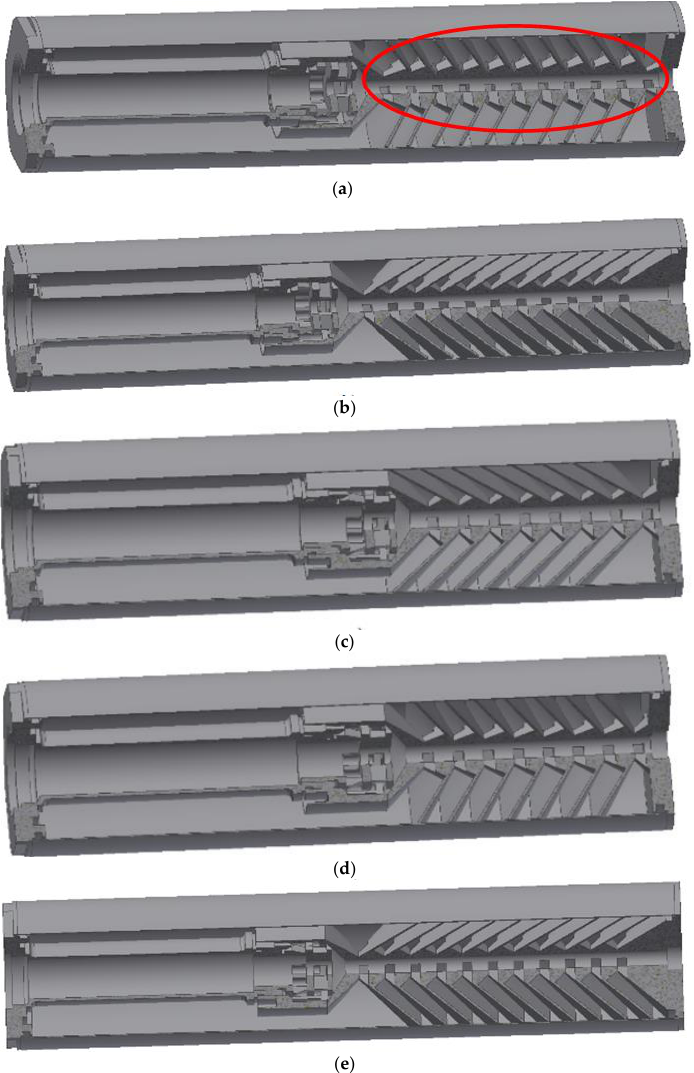
Figure 6. Configurations of test silencers: the angle of inclination of the partitions is changed to 60° ( a ), 135° ( b ), shortened by three partitions ( c ), shortened by three partitions and with the angle of inclination 60° ( d ), the same modification as d but with angle 135° ( e )